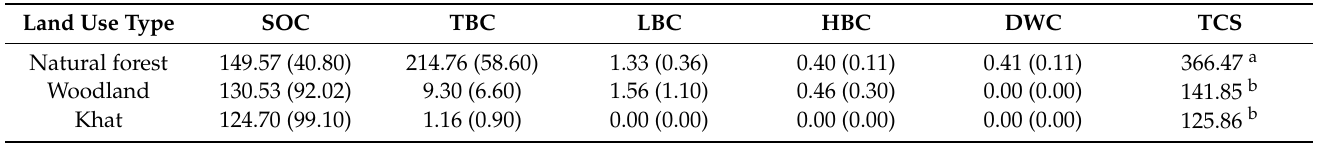
Table 6. Mean carbon stock (Mg ha − 1 ) and percentage contribution (values in brackets) in each carbon pool component and land-use class. Percentage contributions of the soil organic carbon (SOC), total biomass carbon (TBC), litter biomass carbon (LBC), herbaceous vegetation biomass carbon (HBC) and deadwood carbon (DWC) were calculated for each land-use type. The TCS varies between natural forest and other land-uses at a significance level of